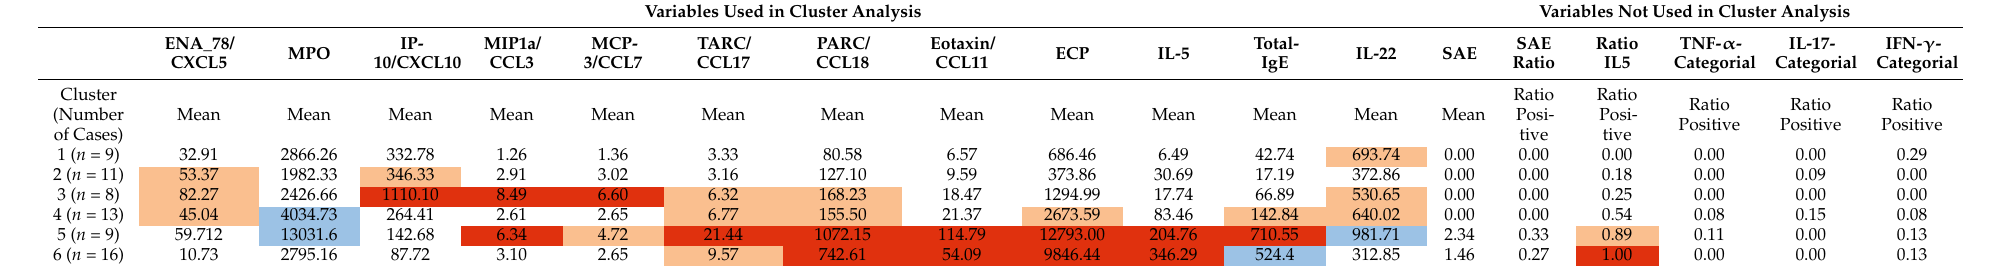
Table 4. Endotype profiling.